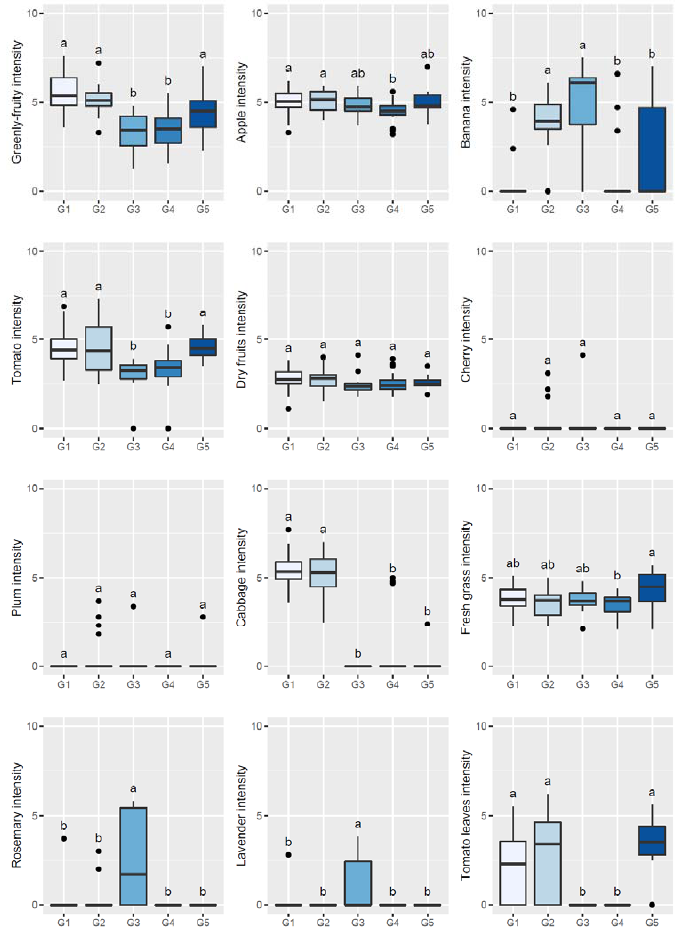
Figure 2. Sensory profile boxplots (olfactory sensations) found in olive oils extracted from olives from centenarian olive trees in the Côa Valley region. Different lowercase letters signify statistically significant differences at a significance level of 5% (one-way ANOVA followed by Tukey’s multi- comparison test).